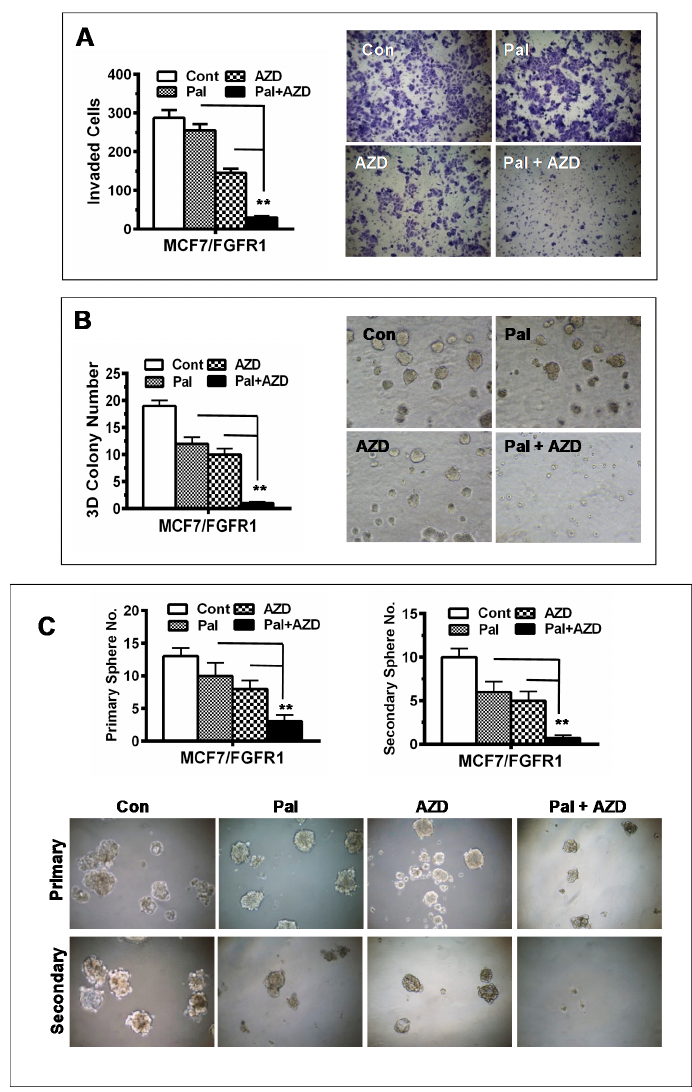
Figure 6. Combination with AZD4547 synergistically enhances palbociclib-induced inhibition of cell invasion and CSC stemness. ( A ) Transwell invasion assays. MCF-7/FGFR1 cells were treated with palbociclib (5 μ M) and AZD4547 (5 μ M) alone or in combination for 30 h in invasion chambers. The invaded cells were stained, counted, and analyzed. ( B ) 3D culture of MCF-7/FGFR1 cells with dif- ferent treatments. The cells were treated with palbociclib (5 μ M) and AZD4547 (5 μ M) alone or in combination in matrigel 3D culture for 7 days, followed by colony imaging and counting. The num- bers of colonies in triplicate were analyzed. ( C ) Effect of drug combination on tumorsphere for- mation. MCF-7/FGFR1 cells were plated in ultra-low attachment plates and treated with 5 μ M AZD4547 and 5 μ M palbociclib, alone or in combination, in triplicate. Primary tumorspheres were counted and imaged after 7 days. Then single cell suspensions harvested form primary spheres were replated for secondary sphere formation for another 7 days. The spheres at each harvest were im- aged and counted. Values in each set of experiments were analyzed with Student’s t- test (** p < 0.01 vs. single drug treatment).